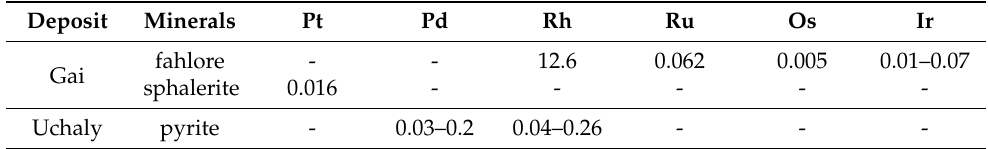
Table 23. Contents of PGE in ore minerals of VMS deposits, LA-ICP-MS data,